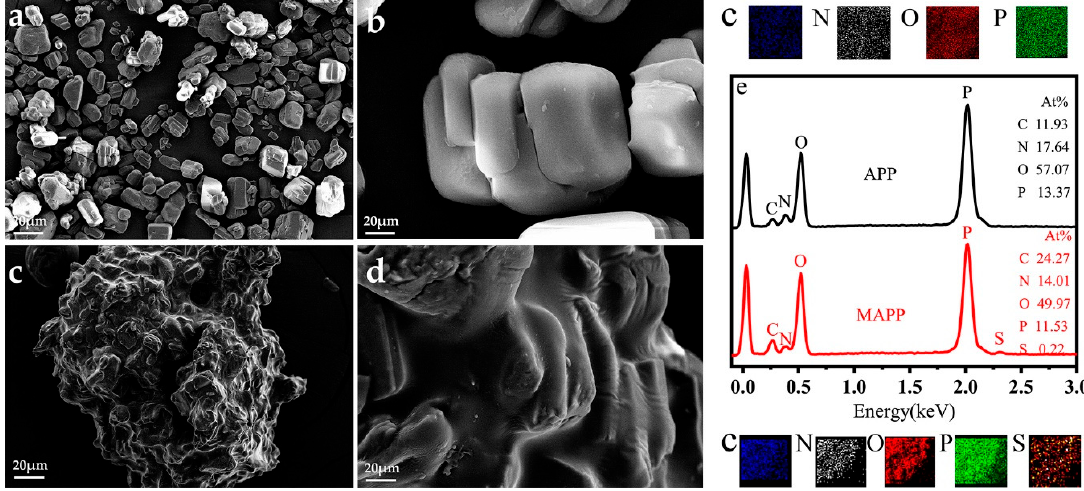
Figure 3. SEM images of ( a , b ) APP and ( c , d ) MAPP; ( e ) EDS image of APP and MAPP.